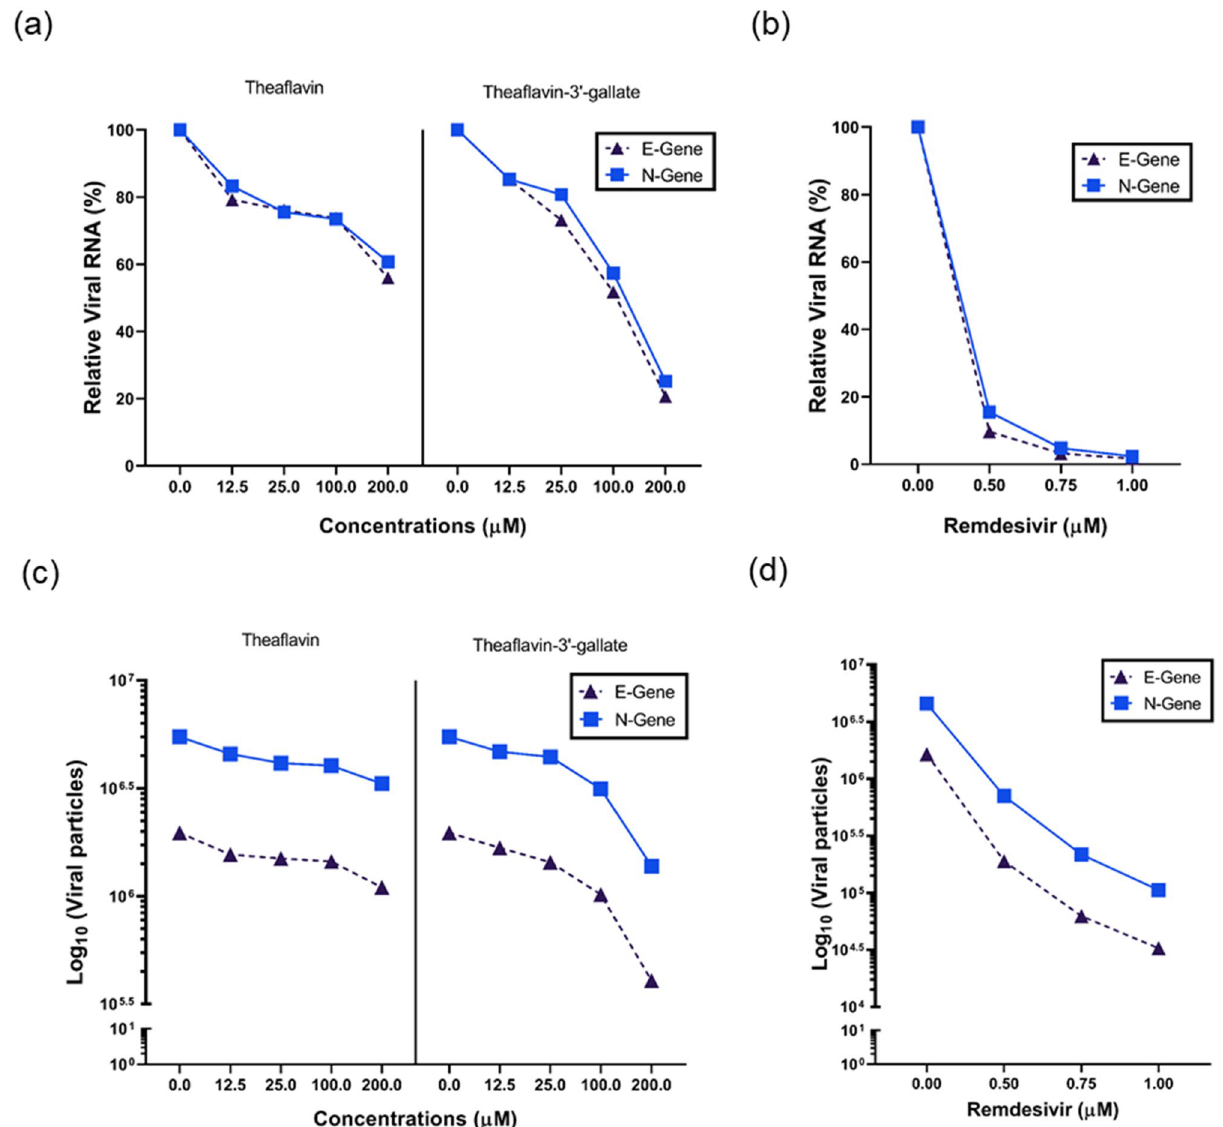
Figure 2. Effect of theaflavin 3-gallate on the inhibition of SARS-CoV-2. Response to theaflavin (positive control), theaflavin 3-gallate, and remdesivir (positive control) in Vero cells at 50, 100, 150, and 200 μM was calculated using quantitative PCR of N and E viral genes. Graphs represent relative viral RNA % ( a , b ) and log reduction in viral particles ( c , d ) after treatment with theaflavin, theaflavin 3-gallate, and positive control remdesivir,